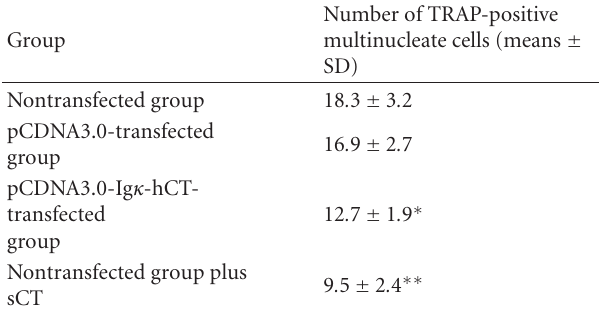
Table 1: The number of TRAP-positive multinucleate cells when osteoclasts were cocultured in vitro with pCDNA3.0-Ig-hCT- transfected, and nontransfected, pCDNA3.0-transfected NIH3T3 cells, or nontransfected NIH3T3 cells plus sCT. Number of TRAP-positive Group multinucleate cells (means ± SD) Nontransfected